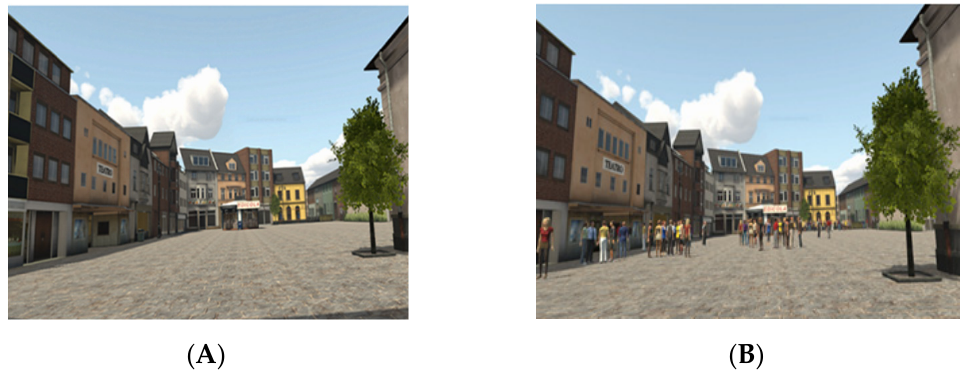
Figure 1. A portion of the square without people ( A , no-people scenario) and with people blocking escape routes ( B , people scenario).